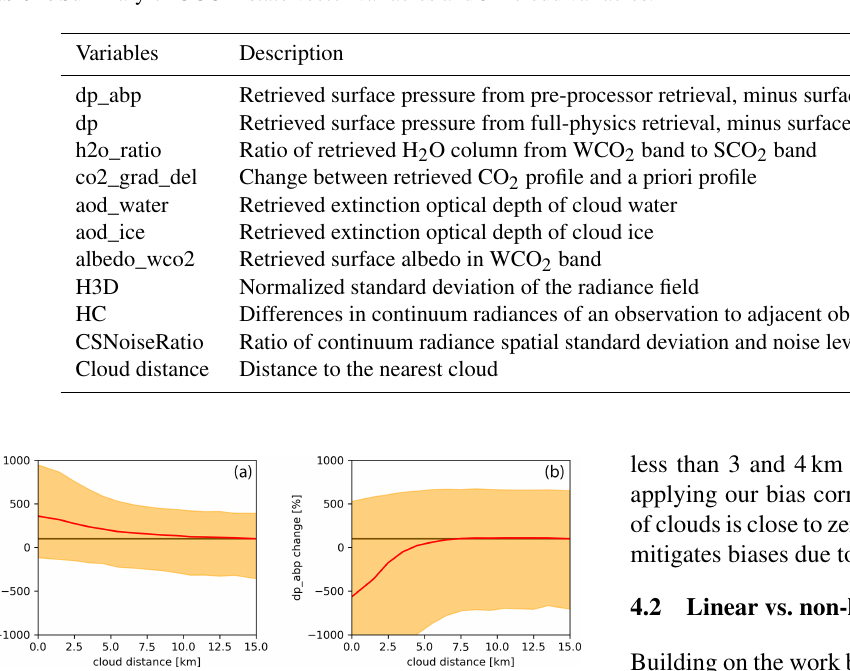
Figure 2. Change in variability and mean in percent of potential features with respect to nearest-cloud distance. Change in mean is shown in red; change in the 5th and 95th percentile is shown in yellow; no change (baseline) is shown with a straight brown line. Change is calculated with respect to feature mean for observa- tions with a nearest-cloud distance of 14 to 15km. Panel (a) shows co2_grad_del, and panel (b) shows dp_abp. Please refer to the text for a description of the two